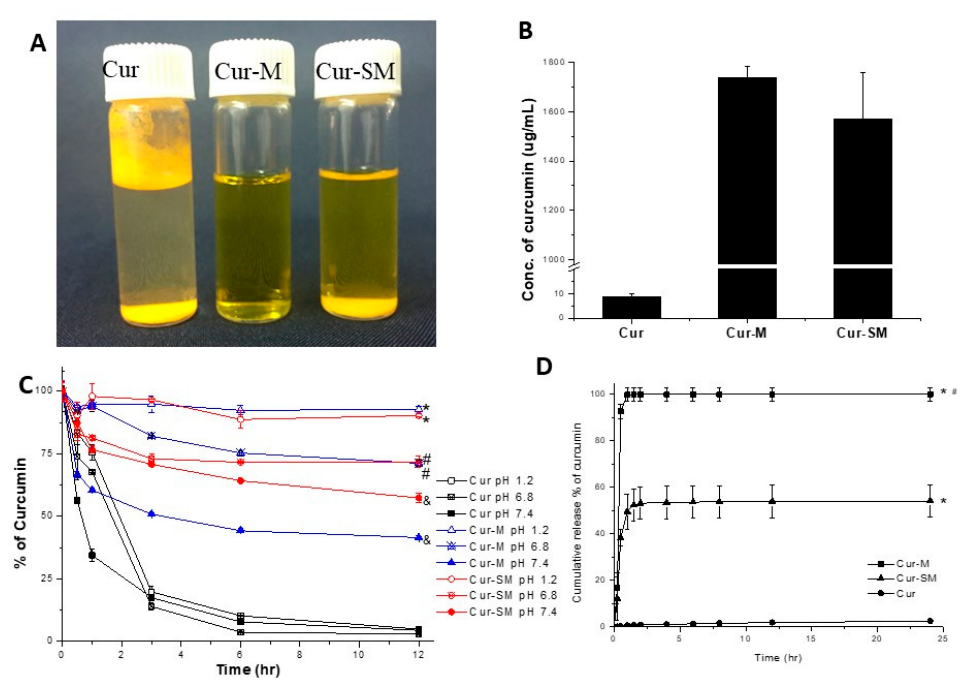
Figure 6. ( A ) The visual appearances of curcumin and curcumin-loaded micelles. ( B ) Aqueous solubility/dispersity. ( C ) pH stability of formulated curcumin in HCl solution (pH 1.2), phosphate buffer (pH 6.8), and phosphate buffer (pH 7.4). Statistically significant differences ( p < 0.05) are indicated by * using native curcumin at pH 1.2, # native curcumin at pH 6.8, and & native curcumin group at pH 7.4 for comparison. ( D ) In vitro release profile of formulated curcumin. Samples were suspended in PBS at pH 7.4 and shaken at 37 °C. Cur: native curcumin; Cur-M: curcumin-loaded self-assembled micelle; and Cur-SM: curcumin-loaded solid self-assembled micelle. Data are expressed as mean ± SD values ( n = 3). Statistically significant differences are indicated by * ( p < 0.05).